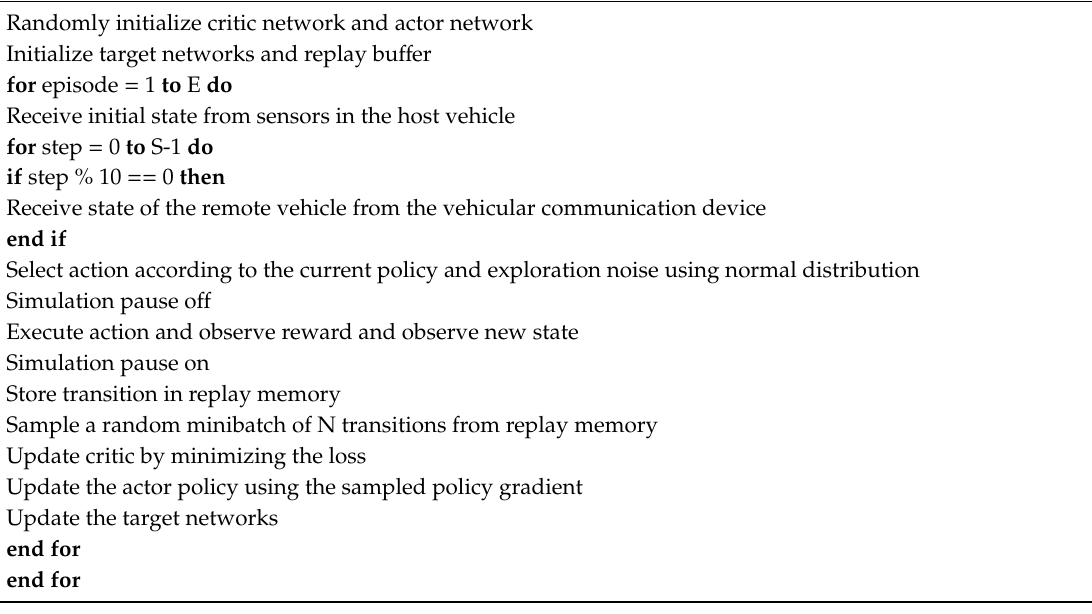
Algorithm 1 . Modification to Deep Deterministic Policy Gradient (DDPG) Training